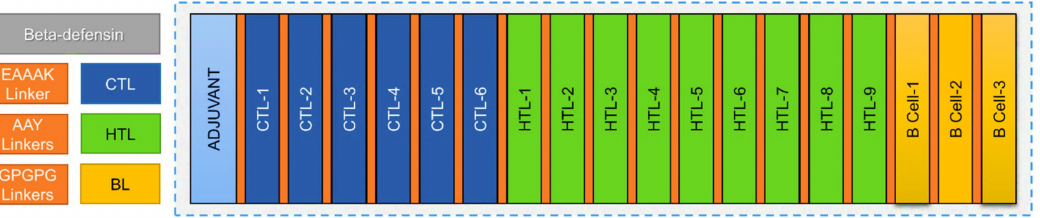
Figure 2. The schematic representation of the multi-epitope-based immunogen construct against E. meningoseptica. A total of 18 immune epitopes, including 6 CTL (blue color) joined by AAY linkers (orange color), 9 HTL (green color) joined by GPGPG linkers (orange color), and 3 BL epitopes (yellow color) joined by GPGPG linkers (orange color), from the selected three proteins (A0A1T3INK9, A0A1V3U124, and A0A1T3FLU2) are shown. The N-terminal-linked adjuvant Human Beta-defensin 3 (cyan color) attached with an EAAK linker (orange color) is also